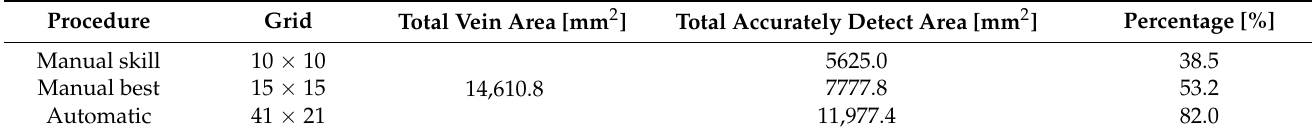
Table 5. Ultrasonic tomography — accuracy results.